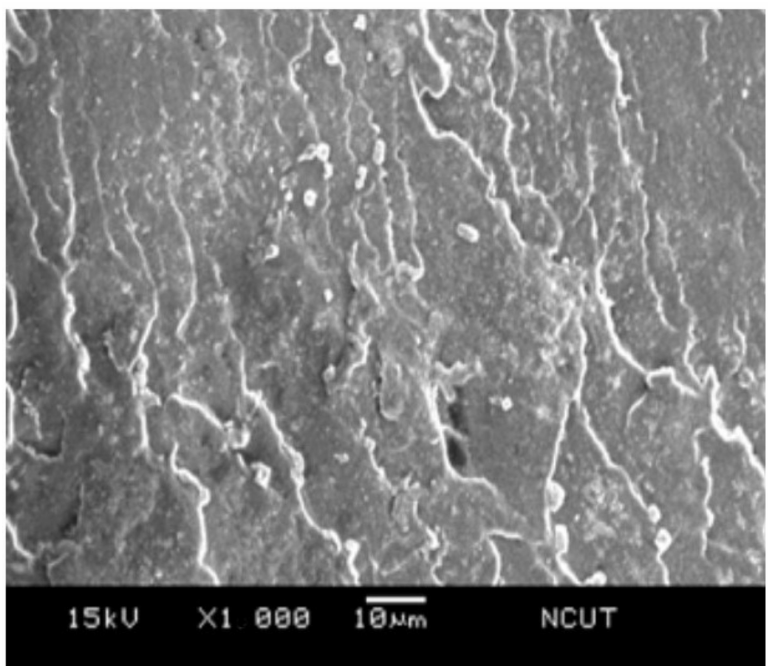
Figure 15. SEM micrograph of the fractured surface on PSA5